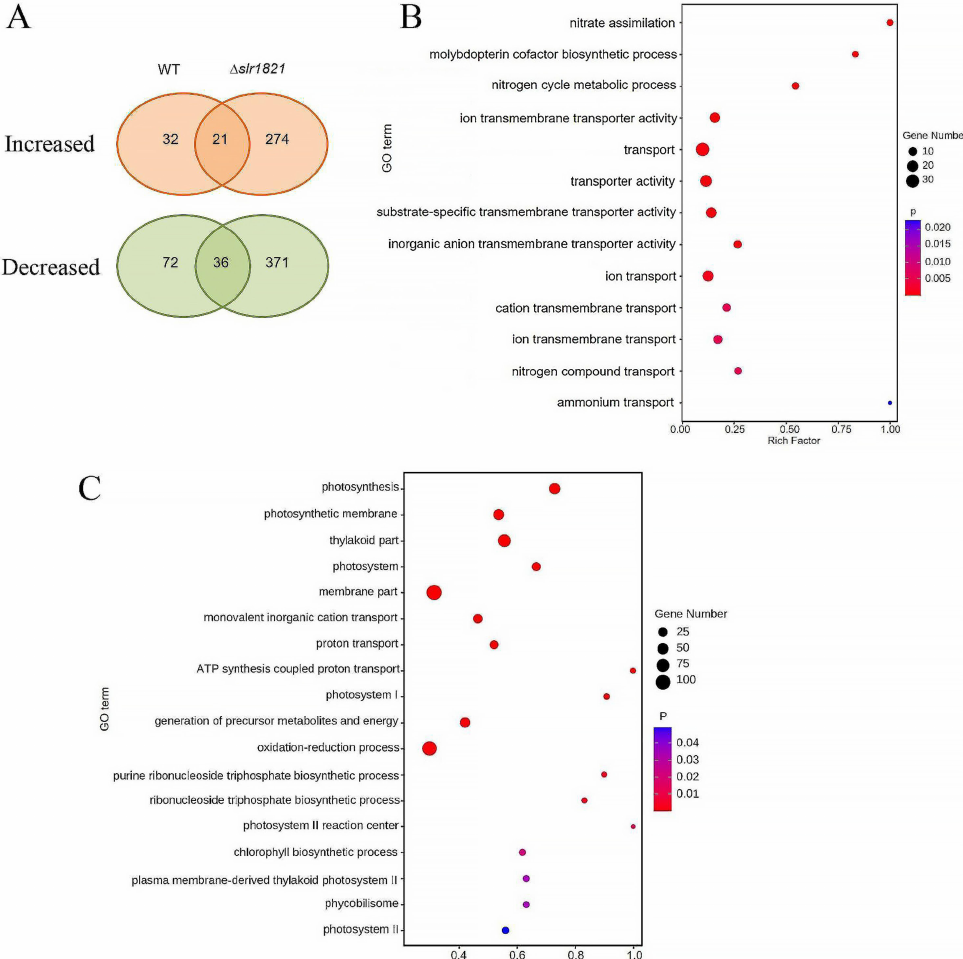
Figure 3. Transcriptional responses to NH 4+ stress in ∆ slr1821 and the wild type (WT). ( A ) Total number of genes which were significantly increased or decreased in response to 30 min NH 4+ stress in ∆ slr1821 and the WT. ( B ) DEGs-enriched representative GO categories ( p < 0.05) in the WT upon NH 4+ stress. ( C ) DEGs-enriched representative GO categories ( p < 0.05) in ∆ slr182 upon NH 4+ stress. 2.3. Slr1821 Is Indispensable for the High Concentration NH4 + -Induced Suppression of